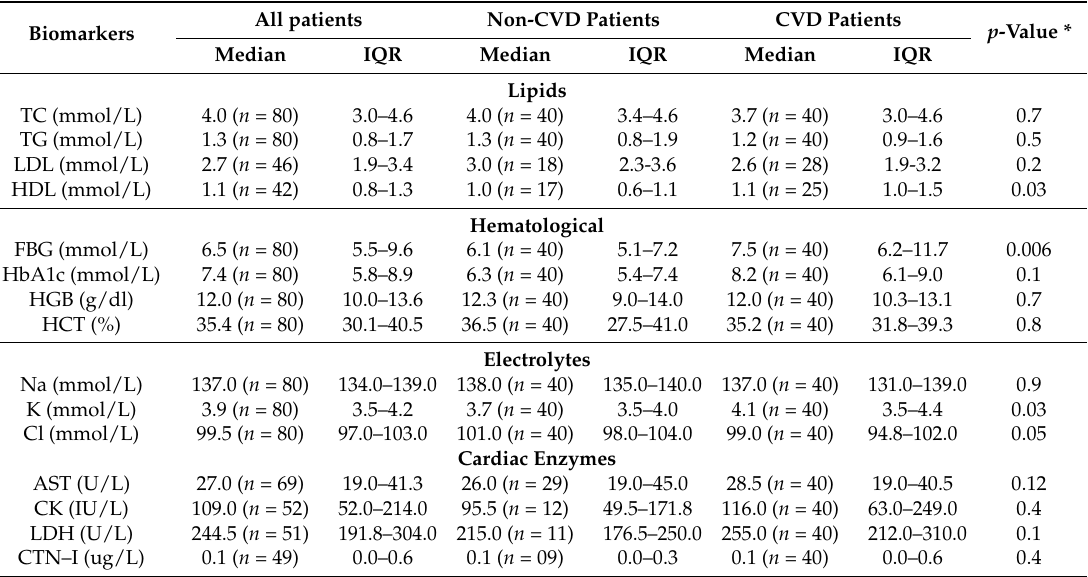
Table 7. Cardiovascular-related